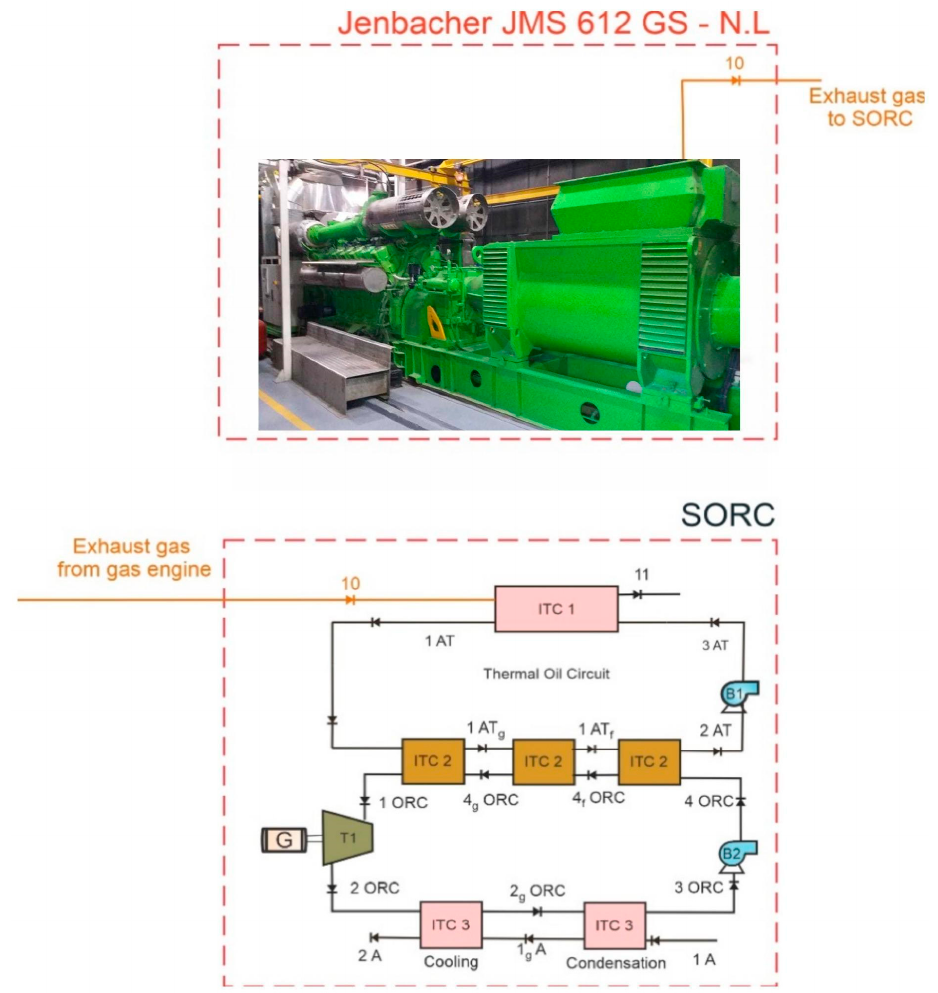
Figure 1. Physical structure of the waste heat recovery (WHR) system coupled with a natural gas engine.